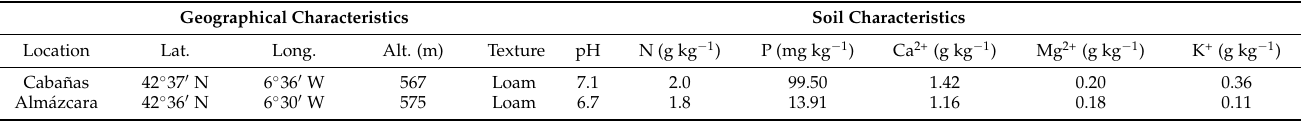
Table 1. Geographical and soil characteristics of the experimental locations where apple cv. ‘Reinette du Canada’ was grown. Geographical Characteristics Soil Characteristics Location